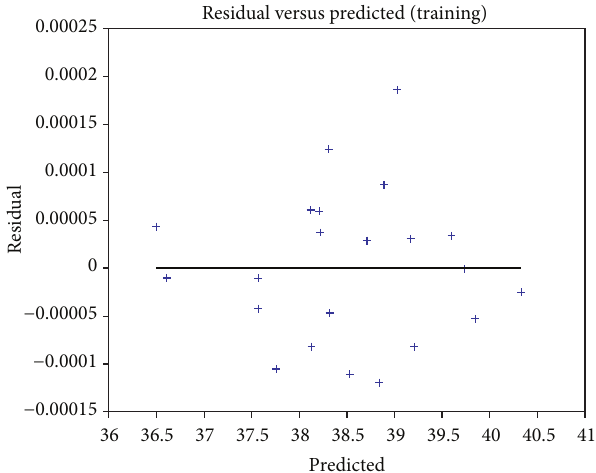
Figure 6: Comparison between residual values and actual values during testing process.